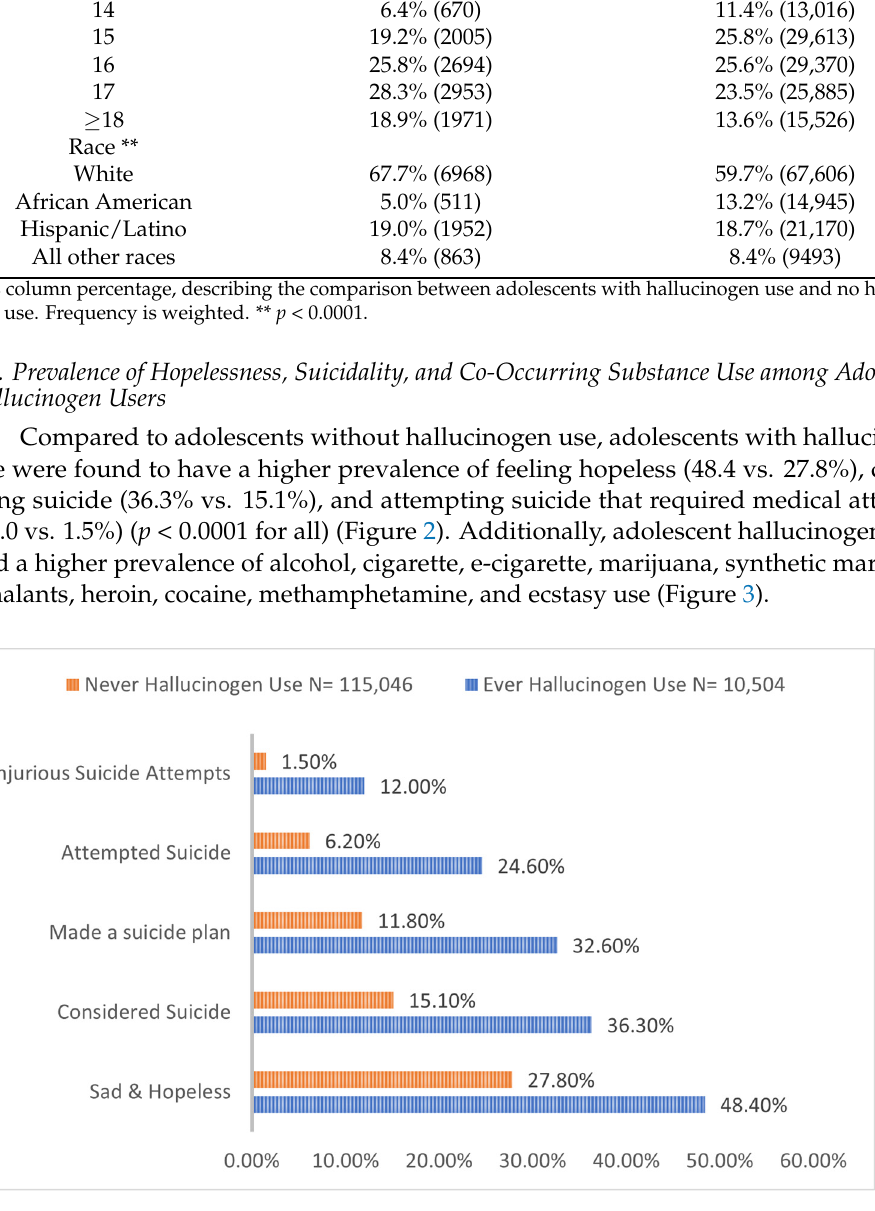
Table 1. Epidemiological characteristics of school-going US adolescents—YRBSS 2001–2019.